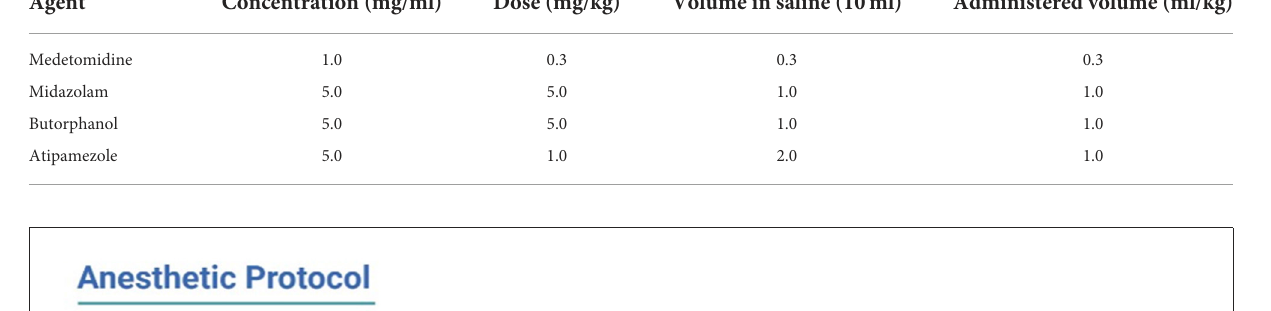
was used with a pre-surgical dose of 5.0 mg/kg/SC, followed by two post-surgery injections